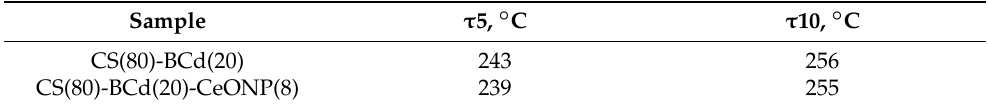
Table 3. The thermogravimetric analysis (TGA) data of the polysaccharides and nanocomposite